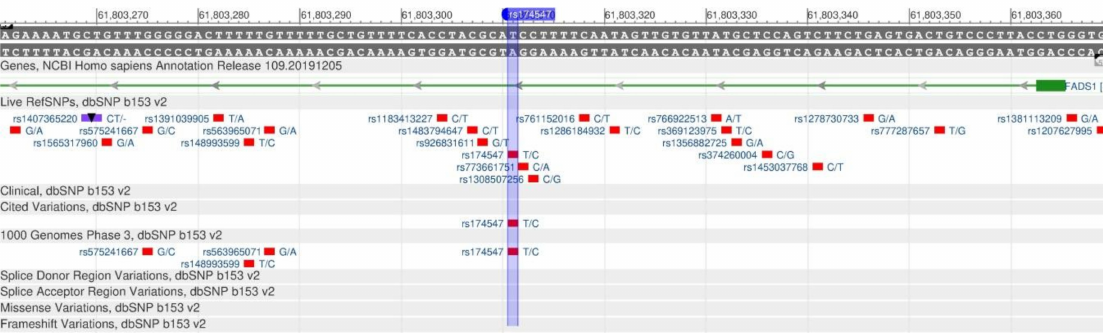
Figure 24. The FADS1 gene region (located on the long (q) arm of chromosome 9) containing the oligonucleotide polymorphism rs174547.